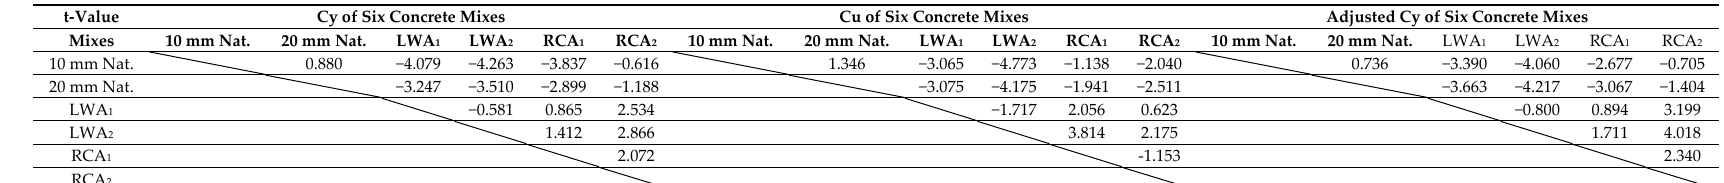
Table 12. Summary of t pooled analysis results at 90-day.